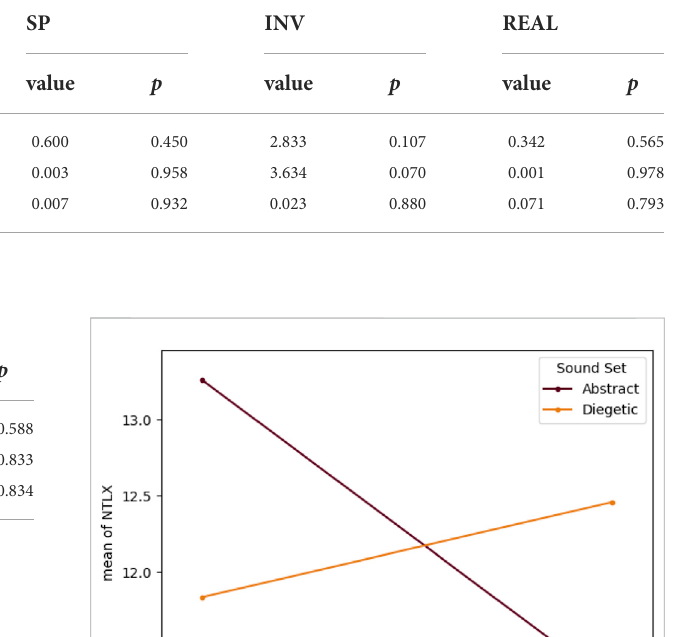
TABLE 6 Statistical analysis of IPQ data.